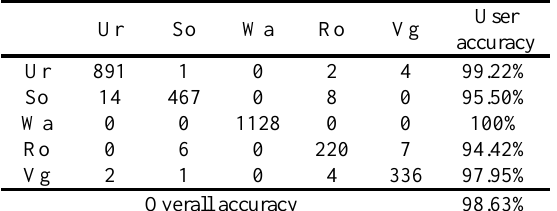
Table 5: Confusion matrix for WMV